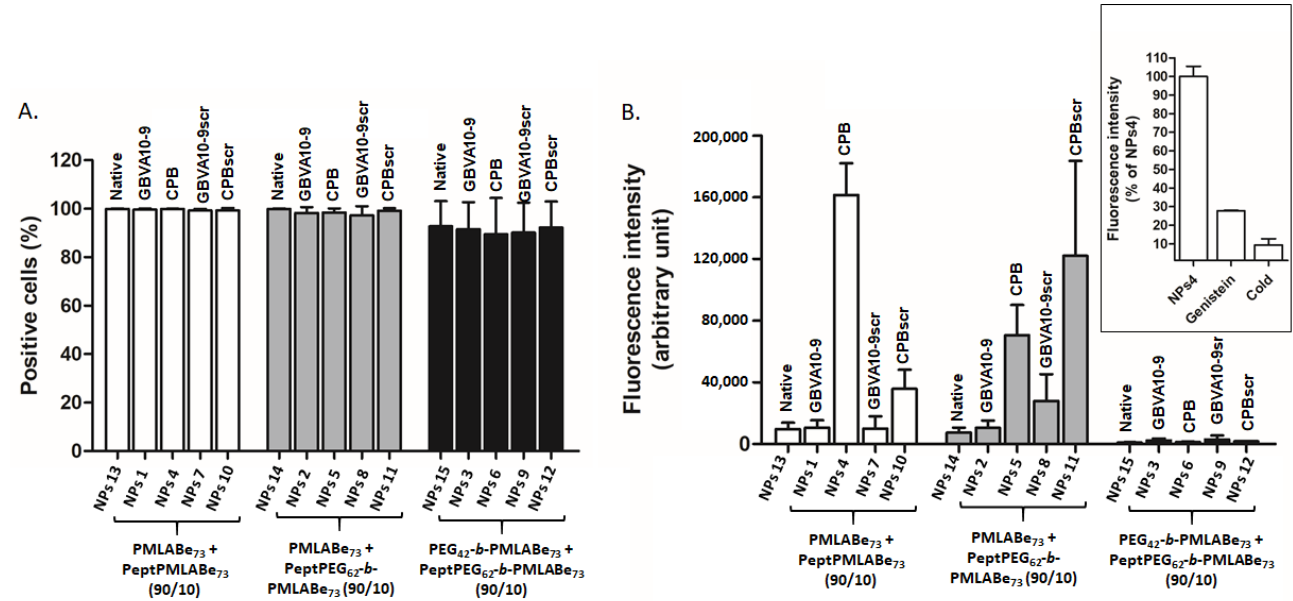
Figure 8. Flow cytometry analysis of NP uptake by HepaRG cells: ( A ) percentage of positive cells, and ( B ) fluorescence intensity, and impact of cold (4 °C) and genistein on NPs 4 uptake.